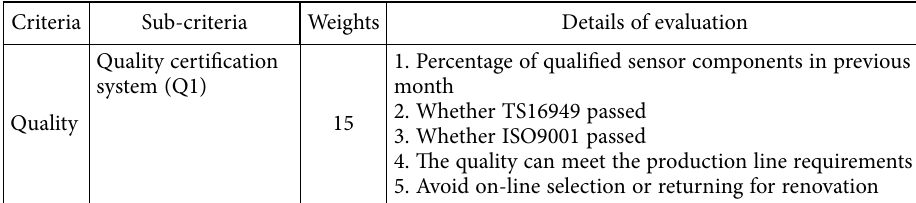
Table 6. Weights and evaluation criteria for sensor